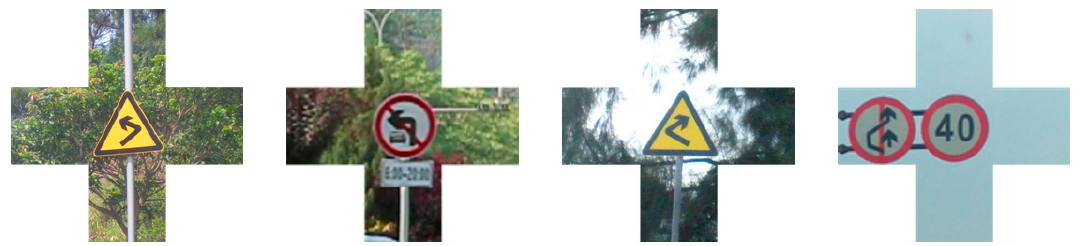
ffi c signs with cross-shaped secondary regions of Figure 7. Traffic signs with cross-shaped secondary regions of interest. Figure 7. Tra Figure 7. Traffic signs with cross-shaped secondary regions of interest.